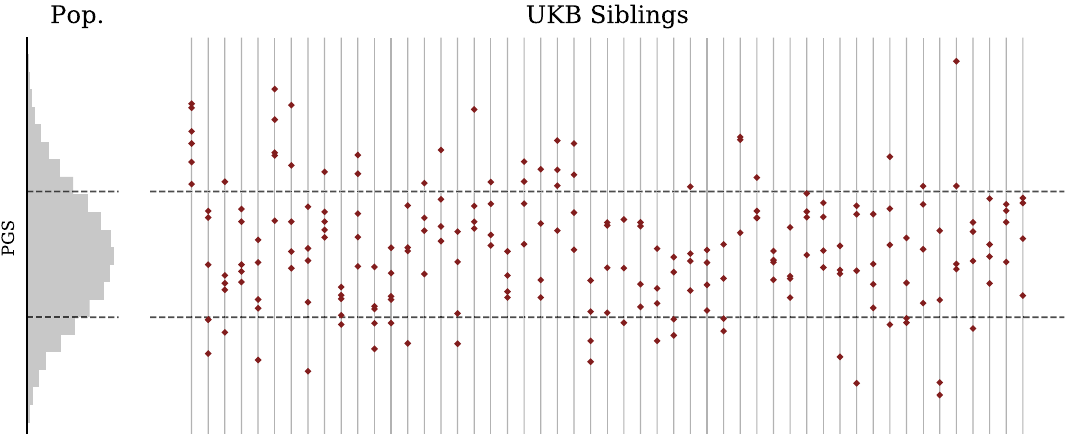
Figure 5. Type 2 Diabetes PGS by family (uncentered) illustrates significant variation within each family. Histogram on left describes UKB general population. Sets of siblings organized by family are displayed on the right to indicate both inter- and intra-family variation as compared to the general population. Note in some families all siblings are above or below the general population average in PGS. Horizontal lines indicate the standard deviation of the general UKB population.